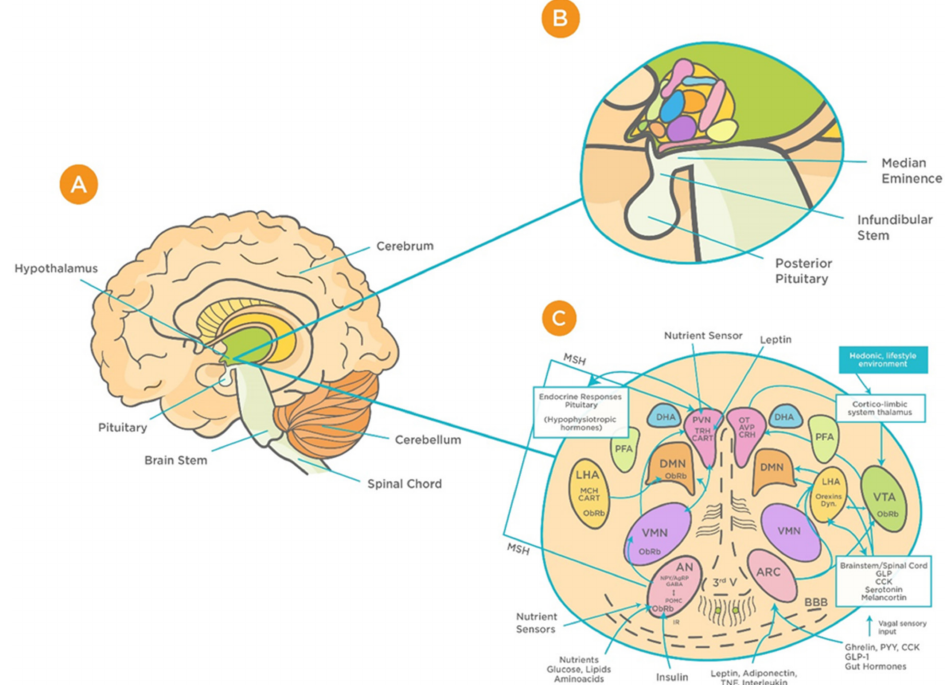
Figure 1. Schematic representation of the functional structure of hypothalamic circuits. ( A ) Location of hypothalamus within the ventral part of the diencephalon. ( B ) Location of hypothalamus in relation to the median eminence,